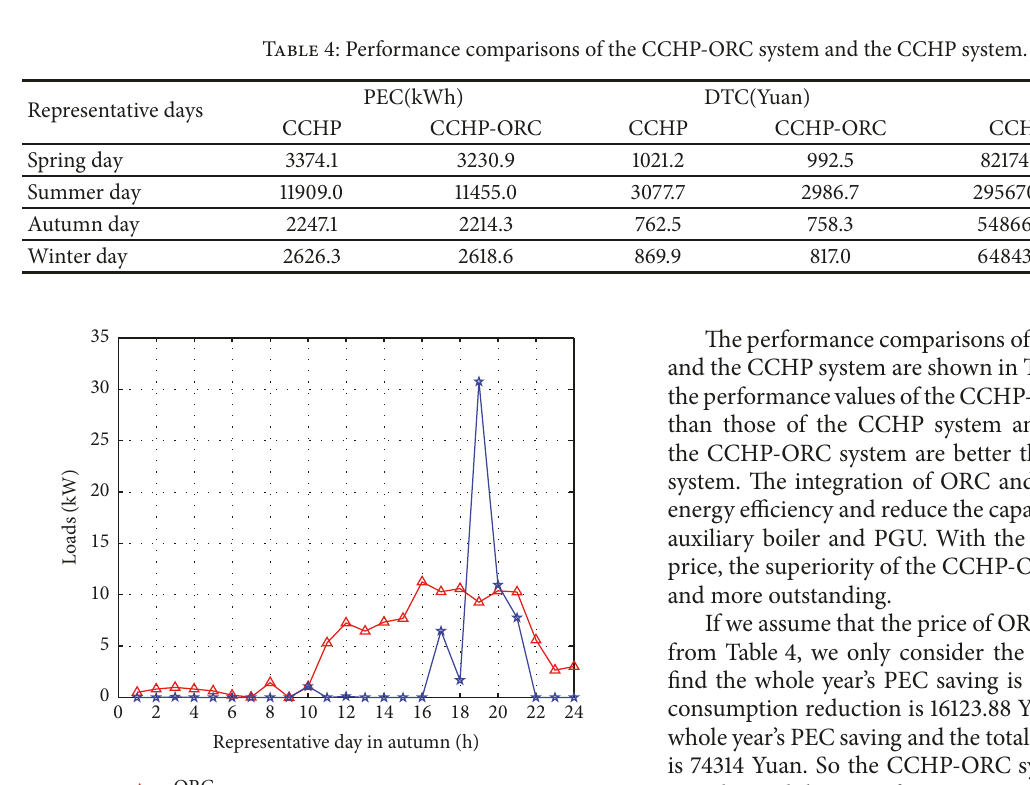
Figure 13: Hourly outputs of the EC and ORC in an autumn day.